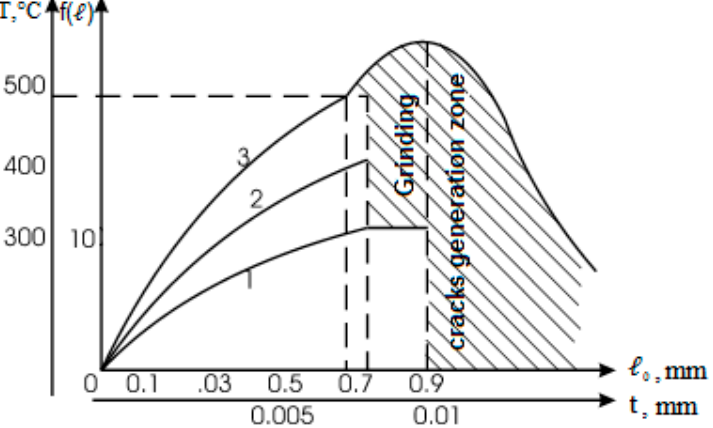
Figure 5. Estimated experimental results for the limit size values of grinding cracks during the process of plasma coatings grinding using abrasive wheels with following characteristics: 1–synthetic diamond bakelite-bonded grinding wheel with 80–100 µ m grain size; 2—synthetic diamond metal-bonded grinding wheel with 200–250 µ m grain size; 3–white aluminium oxide vitrified-bonded grinding wheel with 250–315 µ m grain size.